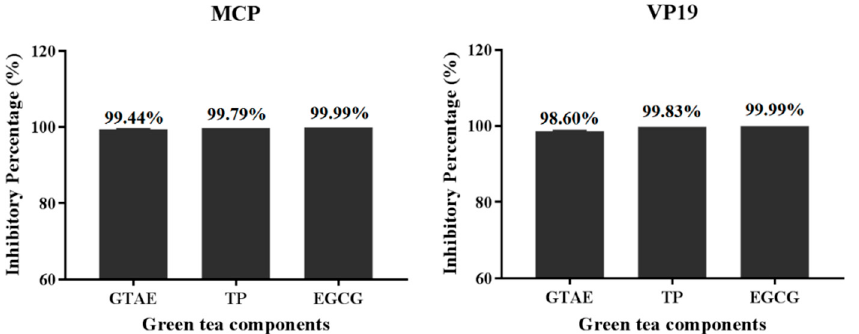
Figure 7. Percentage inhibition analysis of each green tea component against SGIV infection. The